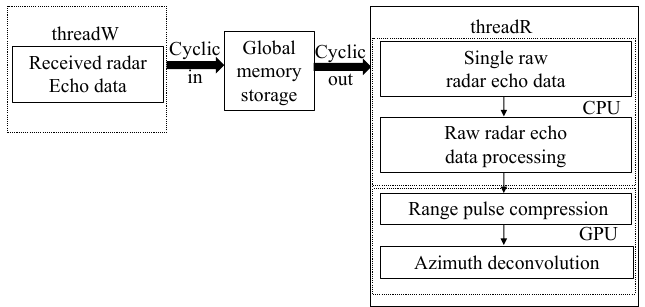
Figure 8. Parallel optimization of the radar echo data receiving and